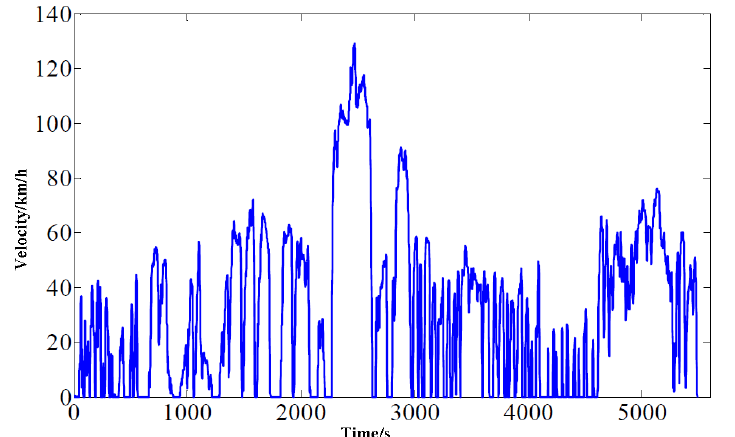
Figure 10. Composite testing driving cycle.